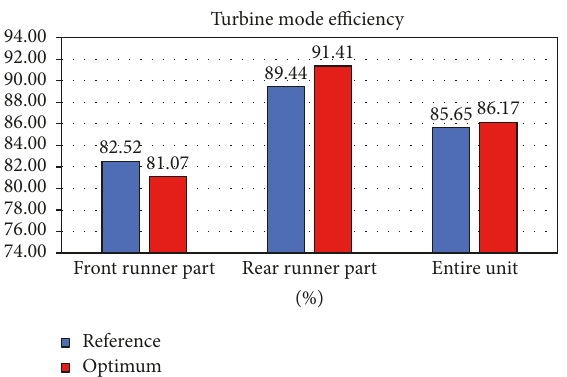
Figure 11: Efficiency distribution for each impeller and entire unit in the turbine